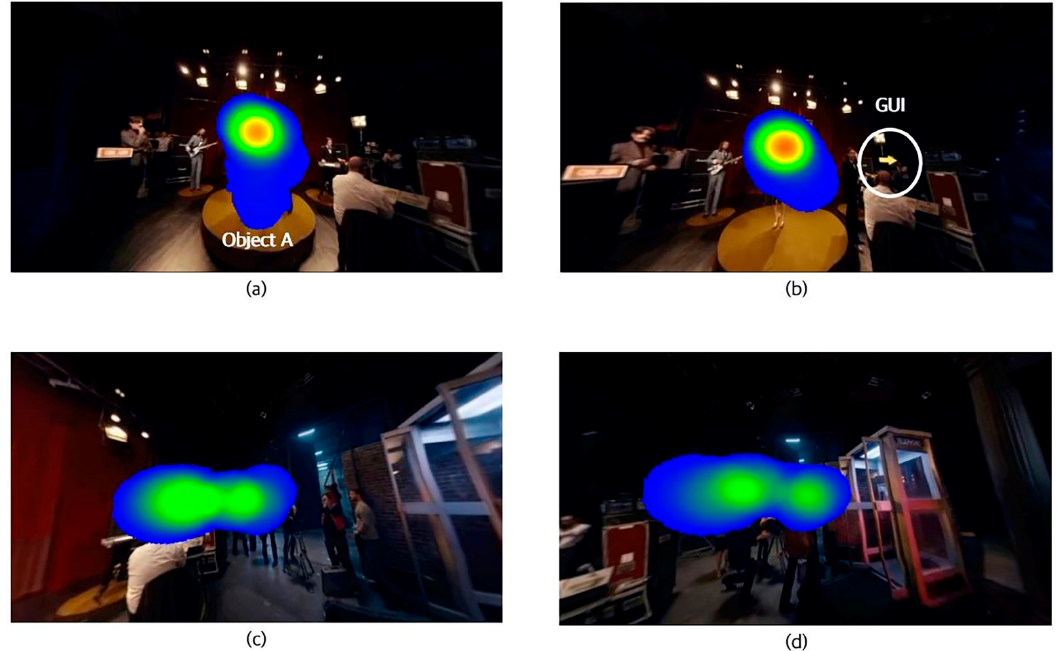
Figure 18. Eye movement according to attention-attracting element of “GUI insertion”. ( a ) The subject’s attention is focused on object A before the GUI is inserted, ( b ) The marked arrow GUI is inserted, ( c ) The user’s attention moves to the GUI, ( d ) The subject’s attention moves in the direc- tion of the arrow GUI. The data in the camera movement experiment were 91.5% (43 subjects). An analysis